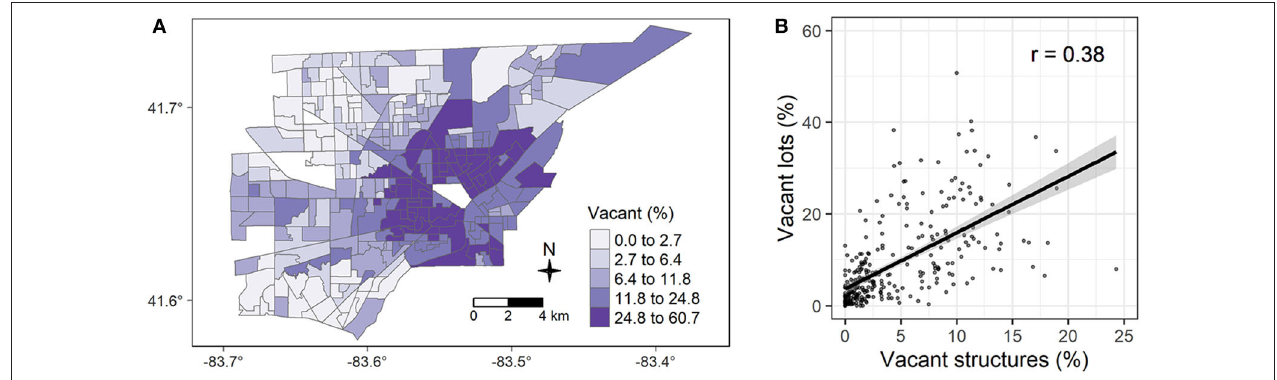
FIGURE 1 | (A) Map of residential vacancy rates (vacant structures plus vacant lots) in Toledo. Filled polygons represent census block groups with ≥ 20 residential parcels. For reference, the downtown core is located near the center of the map in the unfilled (white) block groups. (B) Scatterplot demonstrating the positive relationship between vacant structures and vacant lots within Toledo block groups. Data: Toledo